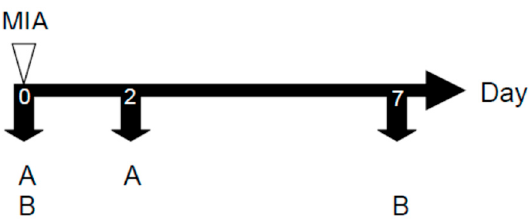
Figure 8. The experimental schedule of mono-iodoacetate (MIA)-induced osteoarthritis model. MIA: first time injected 80 mg/mL MIA, 80 µ L. ( A ) Paw edema measurement; ( B ) Hind-limb weighting bearing measurement.